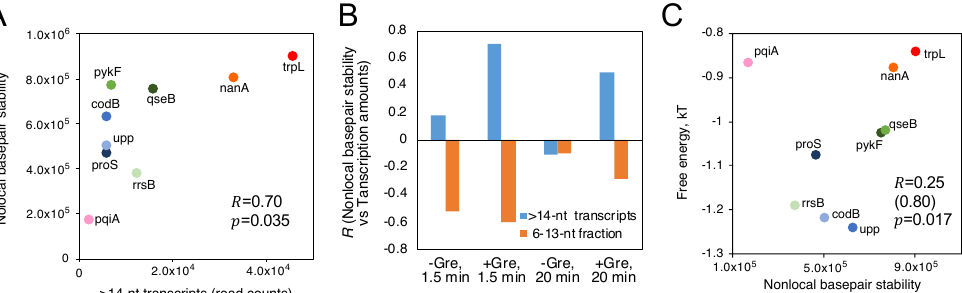
Figure 10. Productivity of transcription depends on nonlocal base pair stability within promoter region. ( A ) Correlation analysis between the nonlocal base pair stability and the number (read counts) of long > 14-nt transcripts. The condition of 1.5 min incubation with NTPs in the presence of Gre proteins was used for the analysis. This condition provided the least abortive transcripts from the 9 promoters on average (see Supplementary Figure S1C). ( B ) The higher positive and negative correlations of nonlocal base pair stability with the long and short transcriptions, respectively, are achieved by the lower production of abortive transcripts. The transcription conditions ( ± Gre proteins, incubation time with NTPs) are indicated at the bottom of each graph. ( C ) Correlation analysis between the dsDNA rigidity and the average FEINC (shown as free energy) calculated for individual promoters within the interval ( − 40 bp to + 40 bp) around TSS. In the panel A and C, Pearson correlation coe ffi cient R and the p -value is shown. In the panel C, R value except pqiA is also shown in